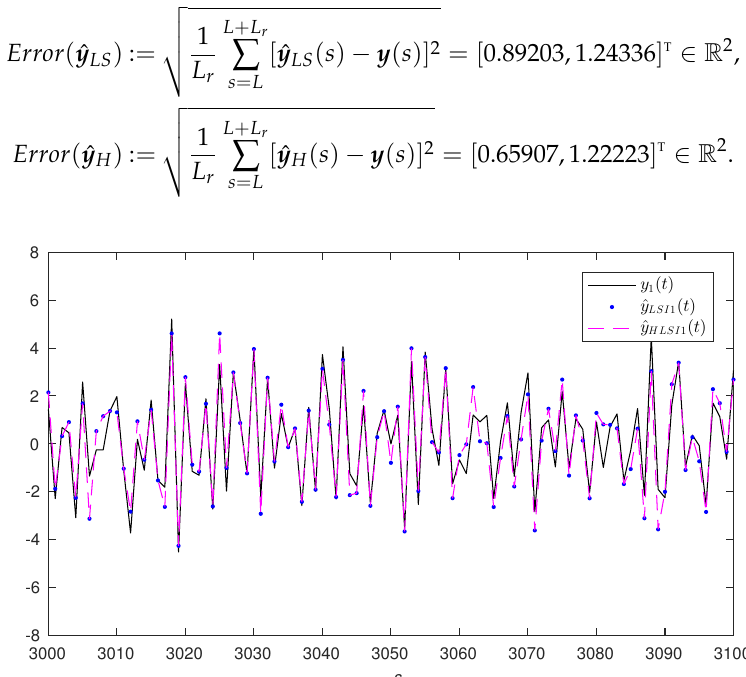
Figure 1. The true output y 1 ( s ) , the predicted outputs ˆ y LSI 1 ( s ) and ˆ y HLSI 1 ( s ) versus s .